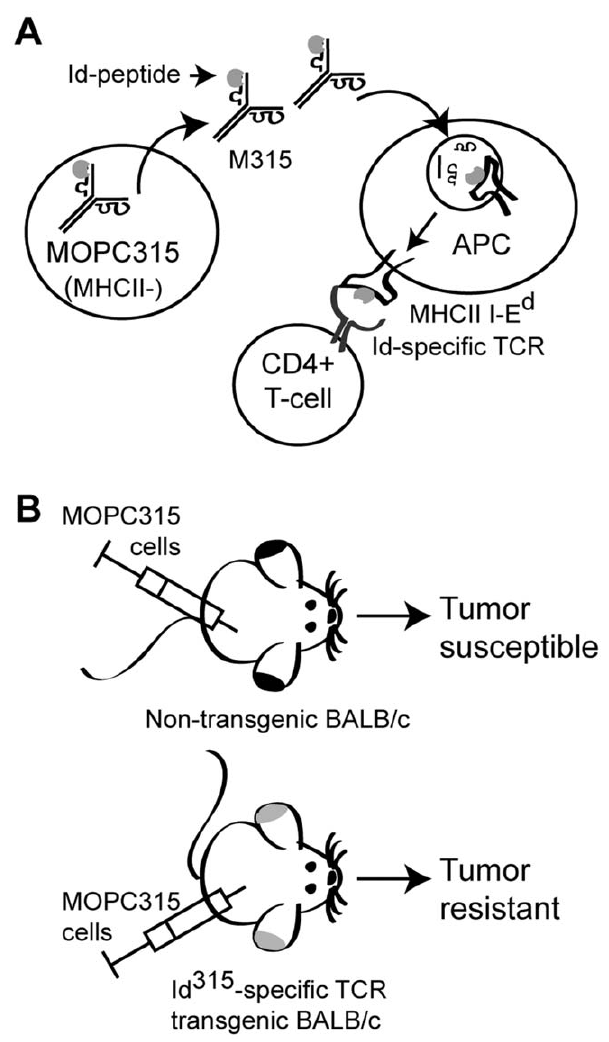
Figure 1. Schematic depiction of the MOPC315 model. (A) The MHCII negative MOPC315 cells secrete the IgA myeloma protein M315. This protein is endocytosed and processed by antigen-presenting cells (APCs), and CD4 + T cells with transgenic TCRs recognize a myeloma- derived idiotypic (Id 315 ) peptide in the context of the MHC class II I-E d molecule. (B) Normal BALB/c mice are susceptible to tumor de- velopment upon injection with MOPC315 cells, while mice with the Id 315 -TCR transgene are resistant towards tumor development. Re- sistance is mediated by tumor specific (Id-specific) TCR transgenic CD4 + T cells [16–19].